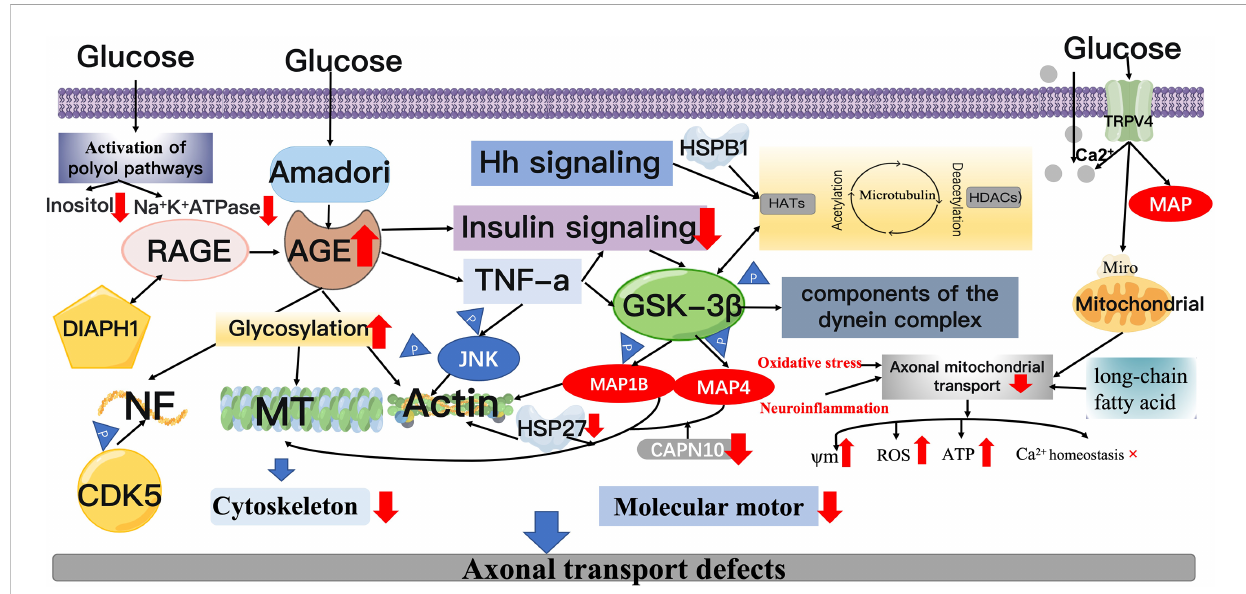
FIGURE 3 Mechanisms of axonal transport injury. AGEs: Hyperglycemia induces the production of Amadori compounds, which undergo a series of changes to form AGEs, which are deposited on the cytoskeleton of peripheral nerve cells. AGEs bind to its receptor, RAGE. On the one hand, the RAGE cytoplasmic structural domain can inhibit GTP-dependent MT aggregation by associating with DIAPH1 on the cytoskeleton, and on the other hand, it can impair axonal transport by interacting with the actin-binding protein mDia1.Espectively, regulate the acetylation and deacetylation cycle of microtubulin in MTs via lys40; GSK-3 b can inhibit the phosphorylation of MAP1B, MAP4, and dynein, affecting MT assembly and stability and actin fi lament remodeling. GSK-3 b can also directly phosphorylate dynein intermediate chains. The NDEL1 bound region that promotes dynein export. CDK5 can be modi fi ed by posttranslational modi fi cations and phosphorylation of NF. JNK3 phosphorylates the motor structural domain of KIF5 and suppresses binding to MT. Heat shock proteins: Maintain the stability of actin cytoskeleton. TRPV4: TRPV4 promotes extracellular Ca 2 + in fl ux, and elevated Ca 2 + levels may directly inhibit mitochondrial axonal transport by binding to the mitochondrial surface protein Miro. TRPV4 also contributes to MT demolition through direct binding to microtubule proteins. In combination with the direct glycosylation damage of